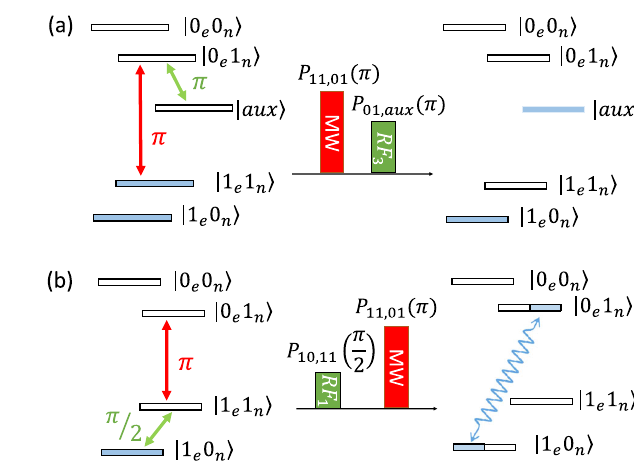
Fig. 5 Sequences for initialization and entanglement generation process. a Preparation of the initial state. A microwave (MW) π pulse and radio- frequency (RF) π pulse are applied successively to achieve the population (cid:1) (cid:3) (cid:1) inversion between 1 1 and the auxiliary energy level aux j i . Hence, an e n almost pure initial state is presented in the two-qubit subspace. b Generation of the entangled state between the electron and nuclear (cid:1) (cid:1) 2